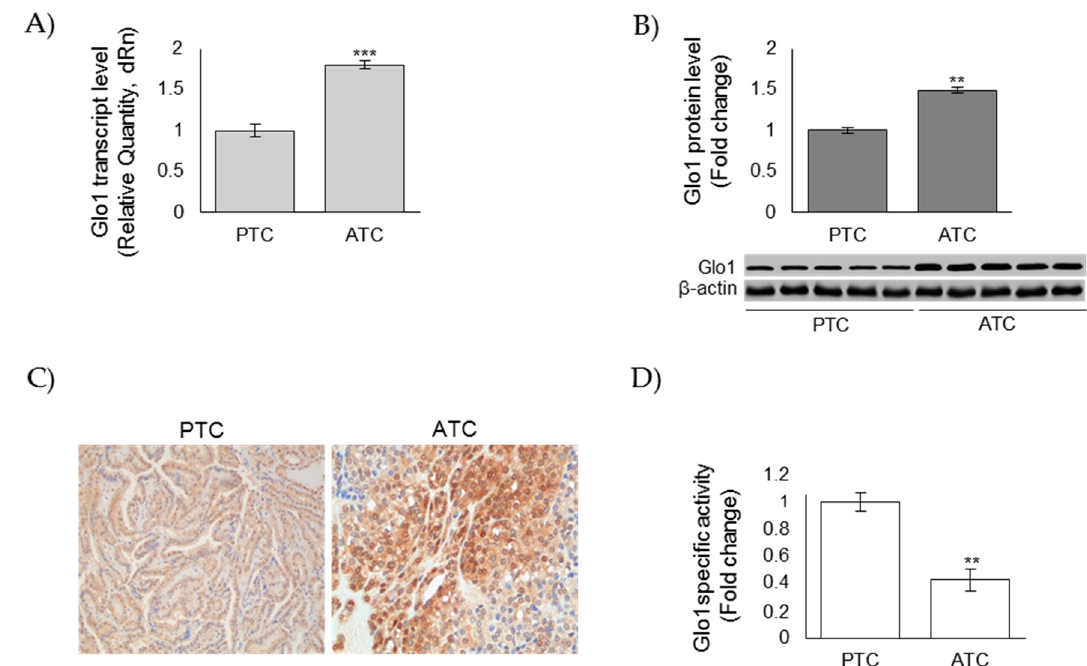
Figure 2. Glyoxalase 1 (Glo1) expression in anaplastic (ATC) and papillary (PTC) thyroid cancer samples. ( A ) Glo1 mRNA expression, evaluated by real-time PCR, after total RNA extraction from five ATC (#1–5) and five PTC samples (#6–10) and cDNA synthesis; ( B ) representative Western blot of Glo1 protein expression measured on lysates from five PTC (#6–10) and five ATC (#1–5) tissues. β -actin was used as loading control. The histogram, representing the densitometric analysis of the blots, indicates mean ± SD of all PTC ( n = 5, #6–10) and ATC ( n = 5, #1–5) samples analyzed; ( C ) representative immunohistochemical staining of Glo1 on PTC ( n = 5, #16–20) and ATC ( n = 5, #11–15) tissues (200 × magnification); ( D ) Glo1 enzyme activity was measured in total protein extracts according to a spectrophotometric method, and increases in absorbance resulting from the formation of S- d -lactoylglutathione were monitored at 240 nm (see Materials and Methods). ** p < 0.01, *** p < 0.01.